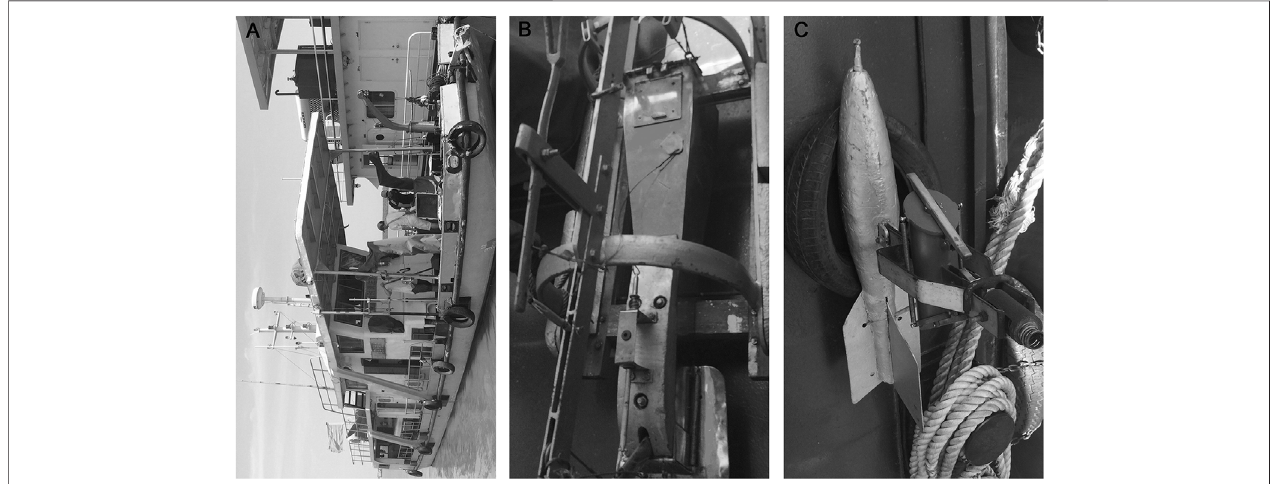
FIGURE 5 | Field photographs of (A) hydrographic survey vessel, (B) bedload sampler (Model Y78-1), and (C) horizontal-type suspended sediment sampler.